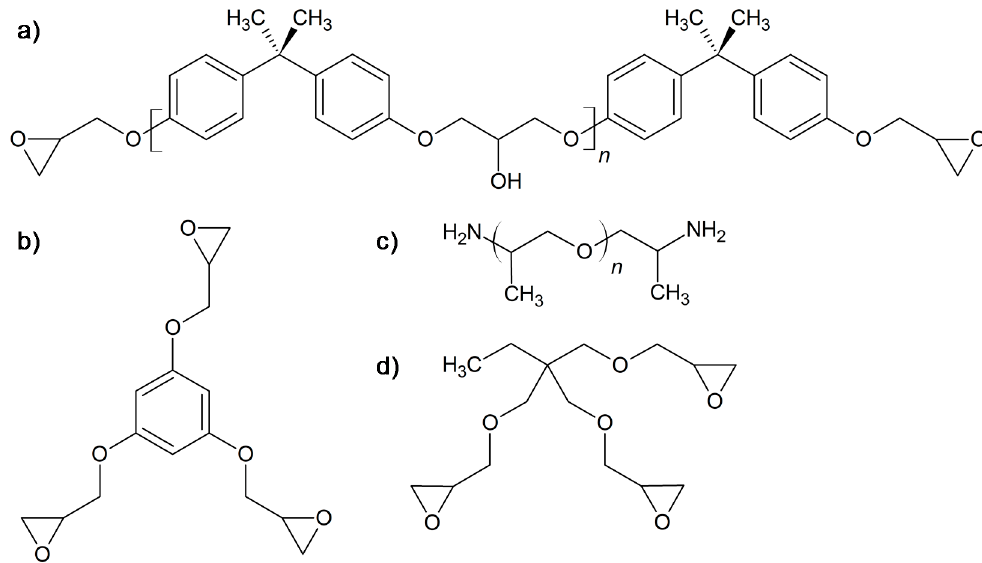
Figure 1. Chemical structure of DGEBA ( a ), triglycidyl phloroglucinol (3EPOPh) ( b ), Jeffamine ® D-400 ( c ), and trimethylolpropane triglycidyl ether ( d ).